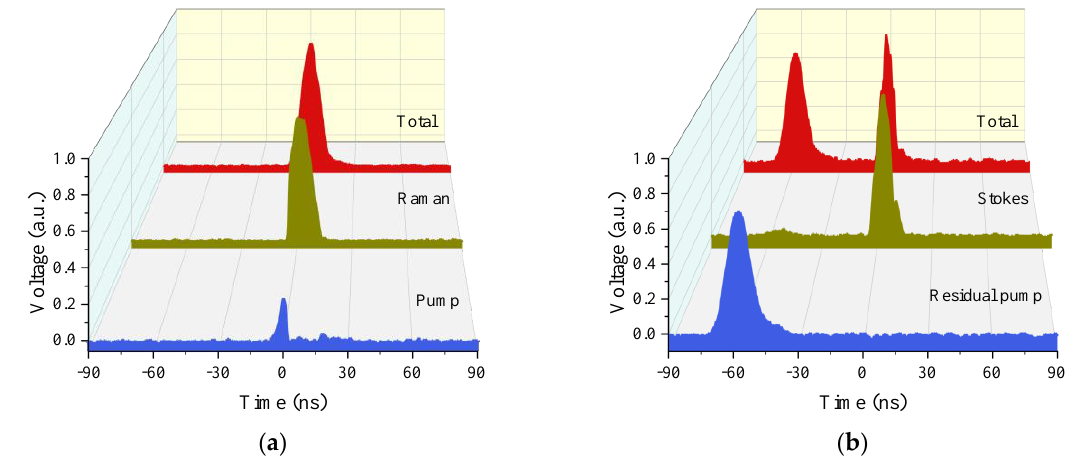
Figure 4. The pulse shapes of ( a ) the forward and ( b ) backward lasers with an incident power of 6 W and a repetition frequency of 1 MHz.